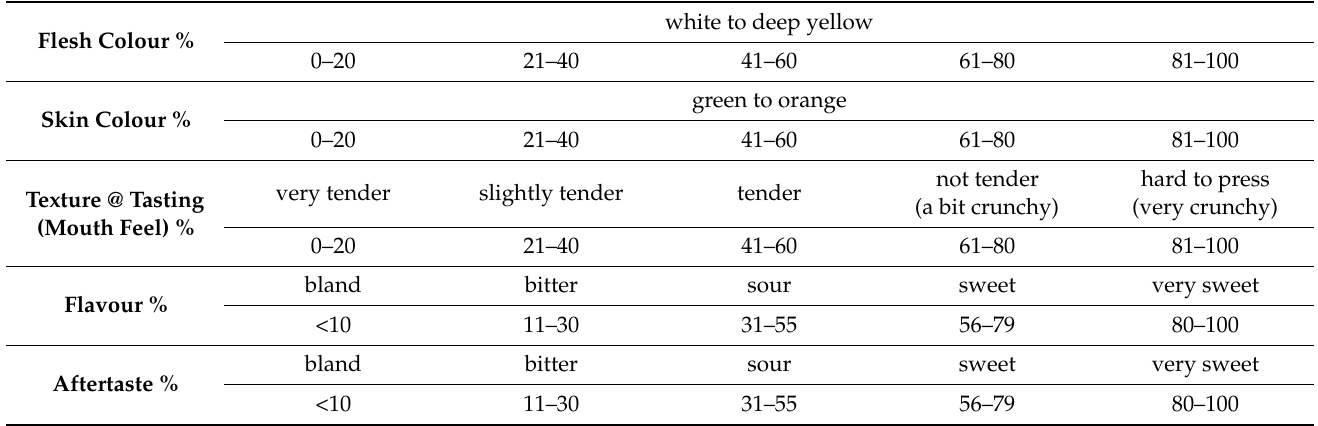
Table 1. Scoring scale for organoleptic properties of Apple